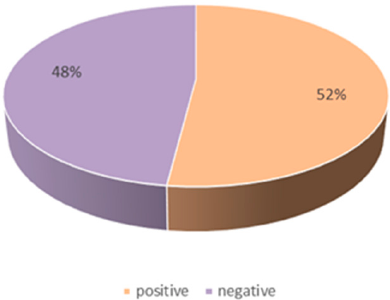
Figure 3. Statistics of the overall emotional value of users.